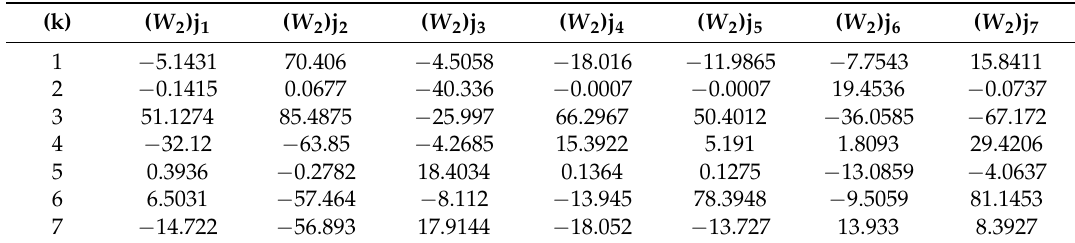
Table 4. Connection weight values for Equation (13).